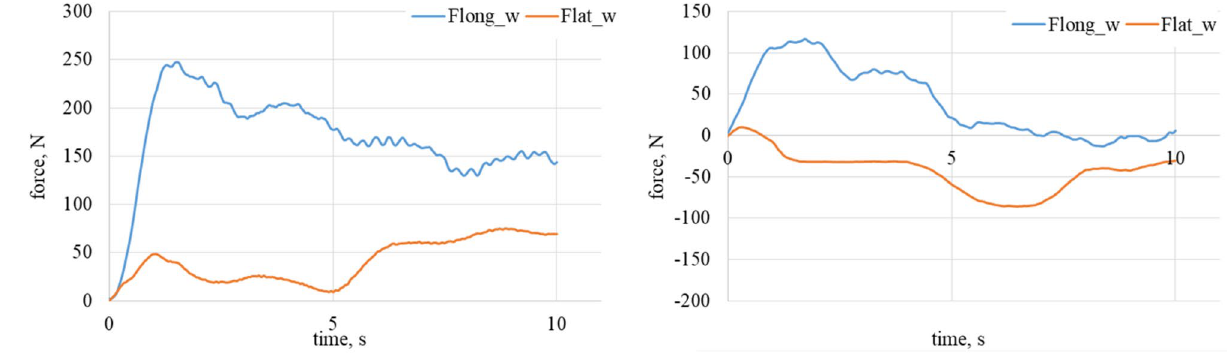
Figure 5. Longitudinal and lateral forces related to the wheel geometry for α w = 0°. On the left waveform: loose snow; on the right waveform: compacted snow.